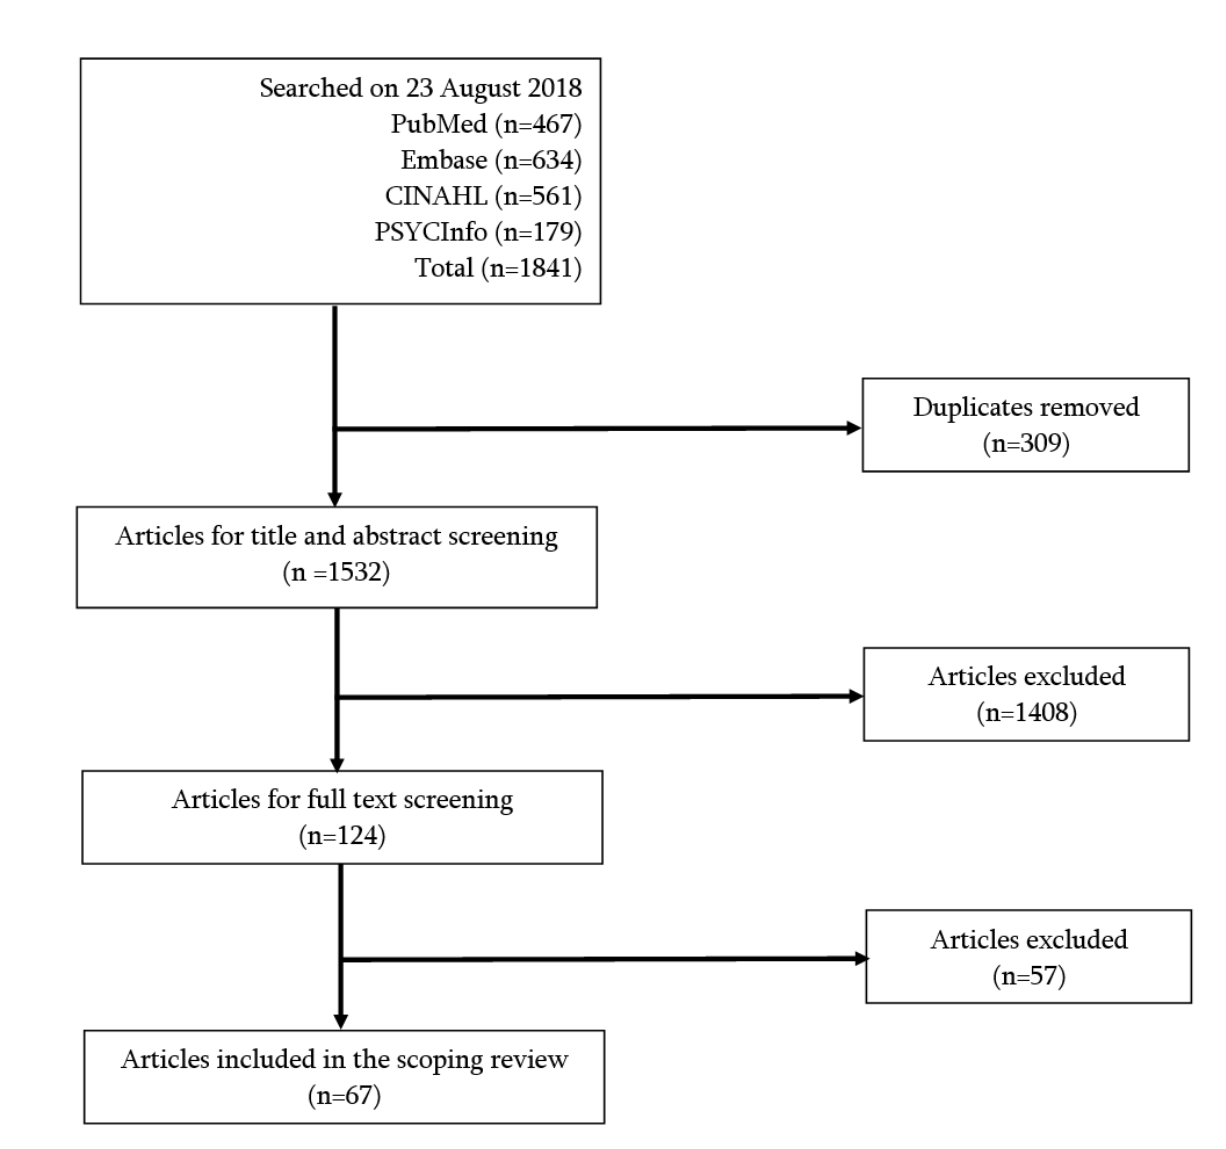
Figure 1. Number of articles included at each stage of the screening